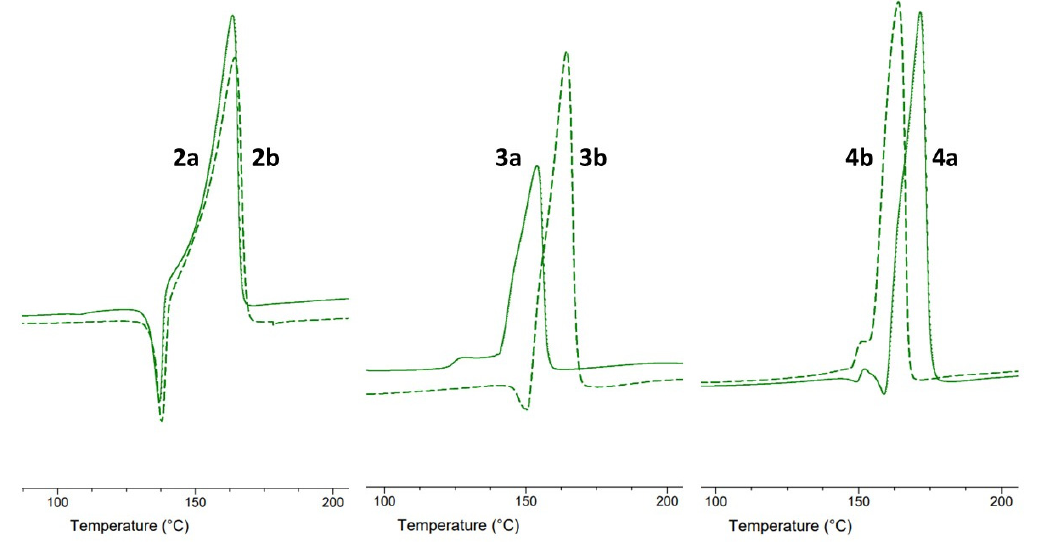
Figure 5. Optical micrographs of ( a ) 2a 11-Aza: 4-Cl-SalA type-I, ( b ) 2b 11-Aza: 4-Cl-SalA type-II,